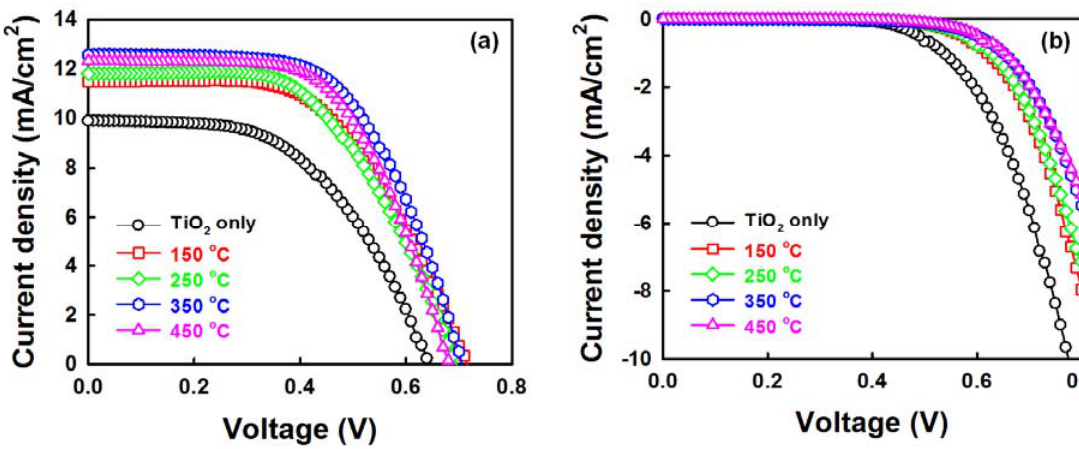
Figure 8. J-V curves of dye-sensitized solar cells (DSSCs) with TiO illumination and ( b ) dark conditions; the annealing temperature of the TiO 450 °C for 30